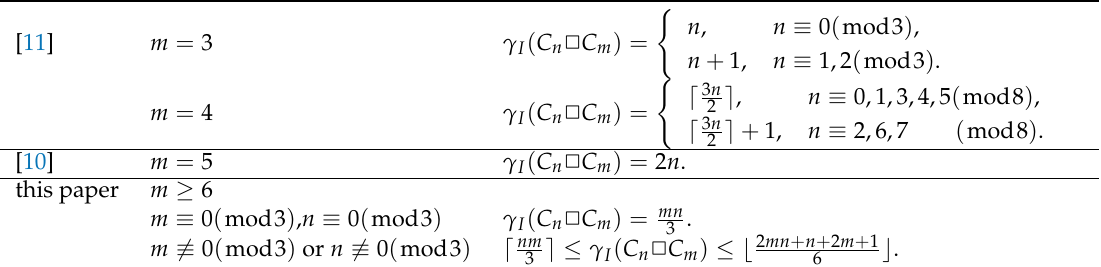
Table 1. Results of the Italian domination number of C n (cid:50) C m